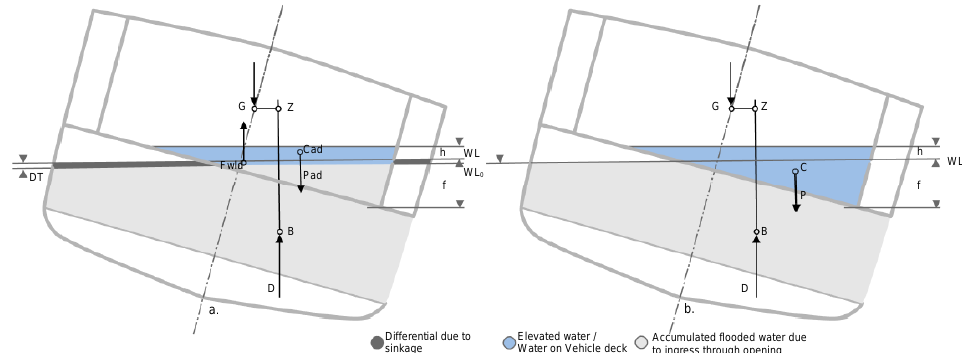
Figure 4. ( a ) Depiction of SEM parameters with water elevation in the vehicle deck at the Point of No Return (PNR)-case of RoRo ship; ( b ) normal method employed by damage stability software considering the floodwater volume as a total water on the vehicle deck inside an undamaged tank [21].